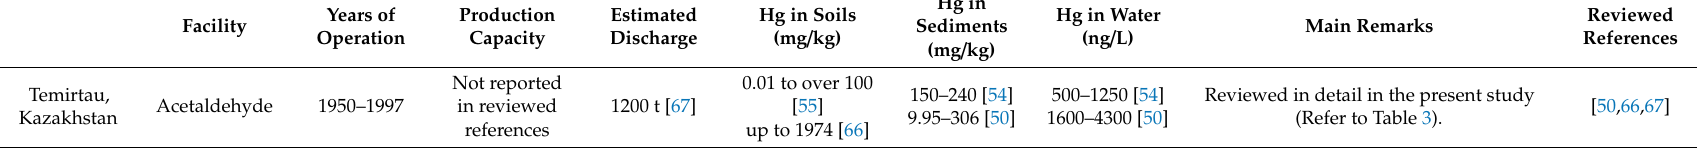
Table 4. Comparison of selected international